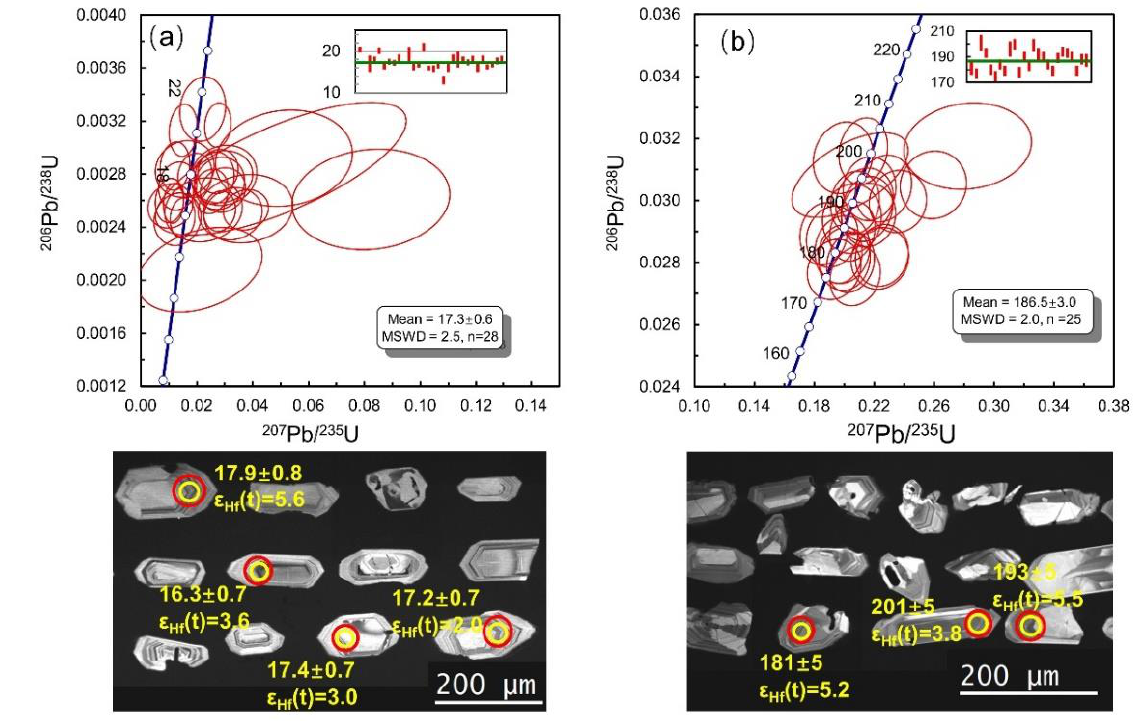
Figure 6. Zircon U-Pb Concordia diagrams and representative cathodoluminescence images, 206 Pb/ 238 U weighted ages and Hf isotopes of the monzogranites ( a ) and rhyolites ( b ) of the Demingding deposit. The small yellow circle represents the analysis point of zircon U-Pb age, while the large red circle represents the LA-MC-ICPMS in situ Hf isotope analysis point. The number next to the analysis point represents the U-Pb ages and the ε Hf (t) values. Table 2. The results of Zircon U-Pb data of monzogranite and rhyolite samples from the Demingding deposit.